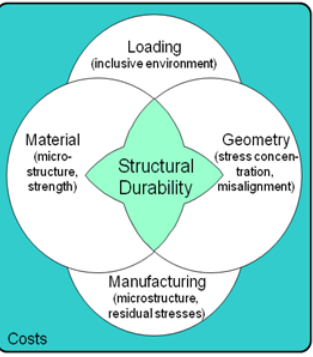
Figure 1: Influencing parameters of durability of welded